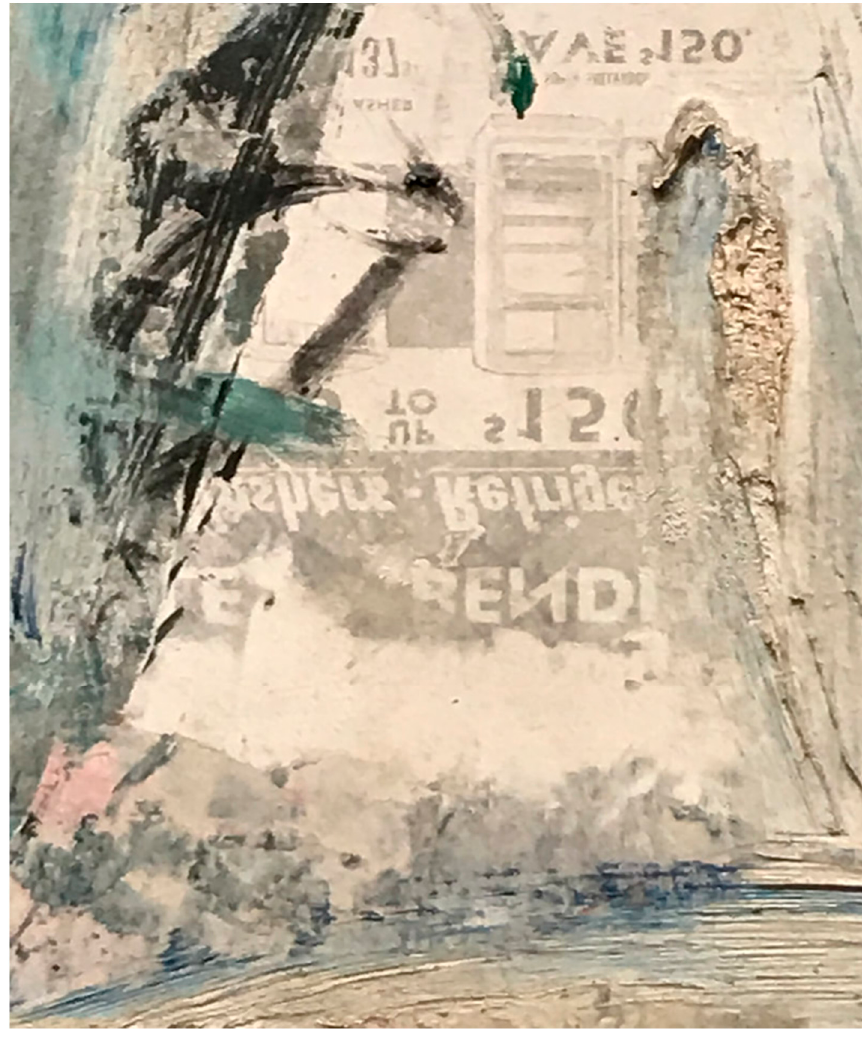
Figure 6. Easter Monday